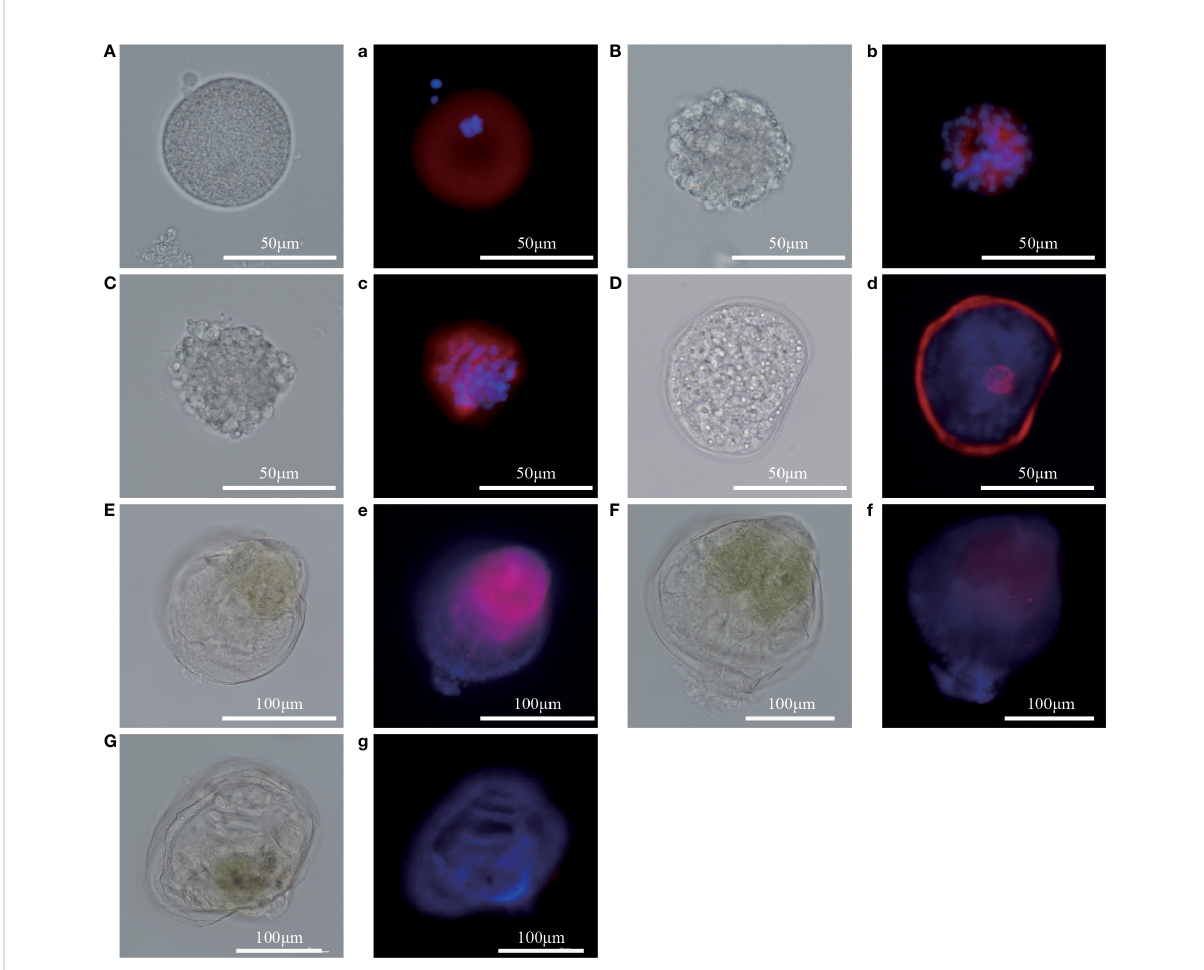
FIGURE 7 In situ hybridization results of Pm5-HTR4 at the developmental stage. (A – G) photos of the experimental group under white light; a – g: photos of the experimental group under fl uorescent light. (A/a) , fertilized ovum; (B/b) , blastocyst; (C/c) , trochophore; (D/d) , D larvae; (E/e) , umbo larvae; (F/f) , eyed larvae; (G/g) , juvenile. Red fl uorescence: in situ hybridization signal of the gene; blue fl uorescence: